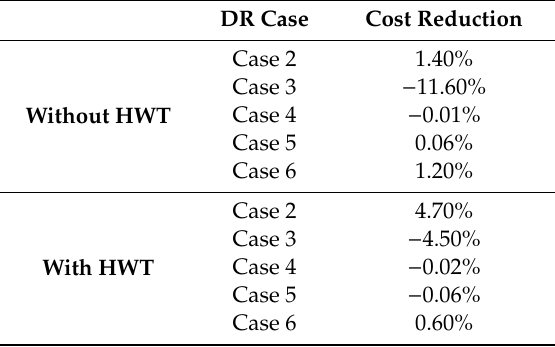
Table 4. Production cost reduction if 100% of building stock participates in each DR strategy.